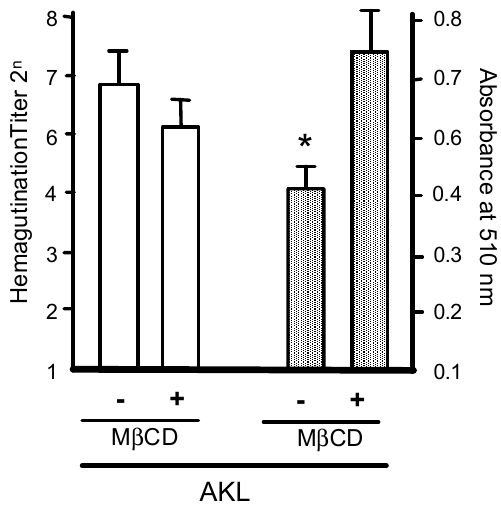
Figure 5. Pretreatment with MβCD suppresses the inhibitory effect of AKL on SLO-induced hemolysis. White columns: hemagglutination activity of AKL in RBCs pretreated with (+) or without (−) 12.5 mM of MβCD. Shaded columns: inhibitory effect of pretreatment with 12.5 mM of MβCD on hemolytic activity of 2 mg/mL AKL in RBCs in the presence of SLO. Error bars: SE from three independent cell preparations assayed individually. * p < 0.01 in comparison with negative